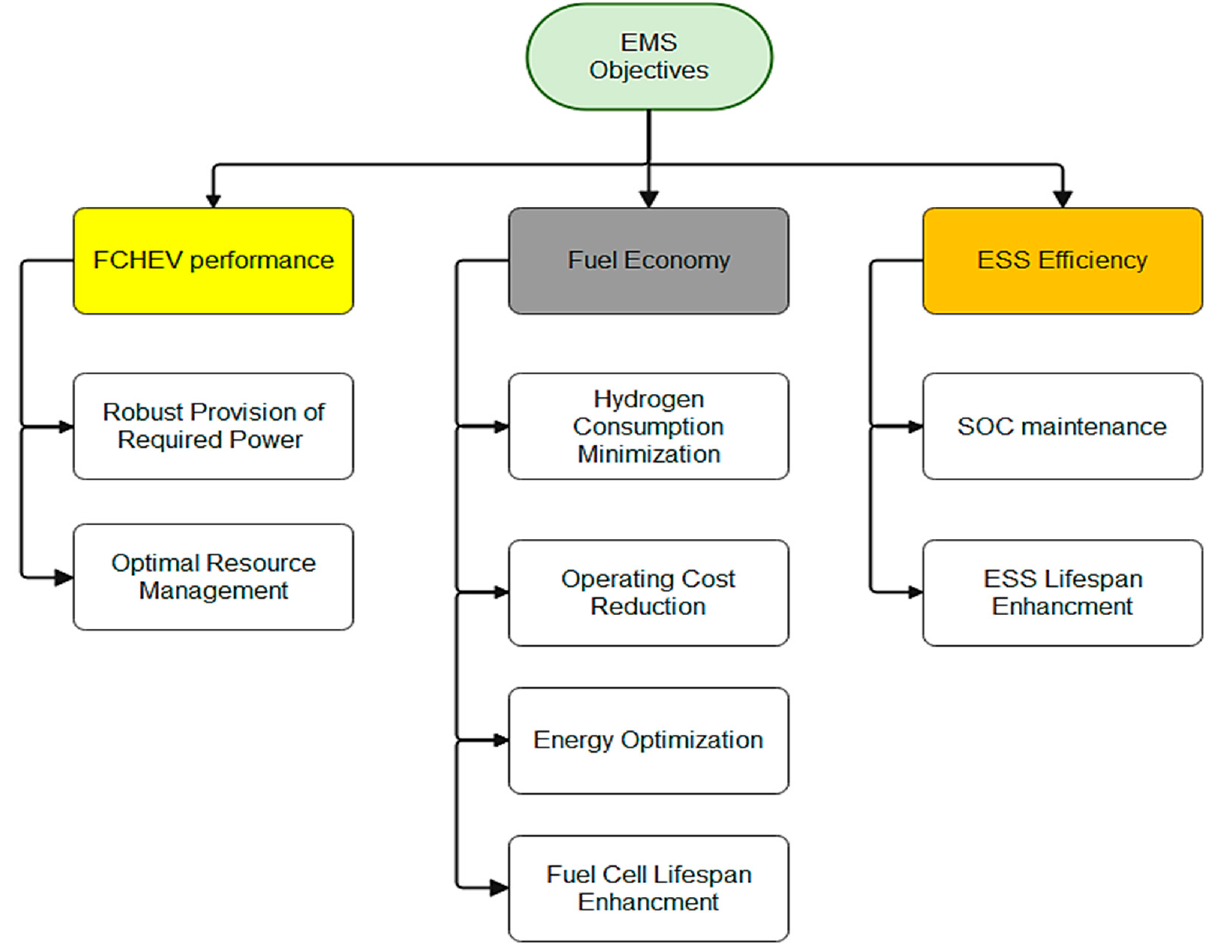
Figure 6. EMS primary design objectives.